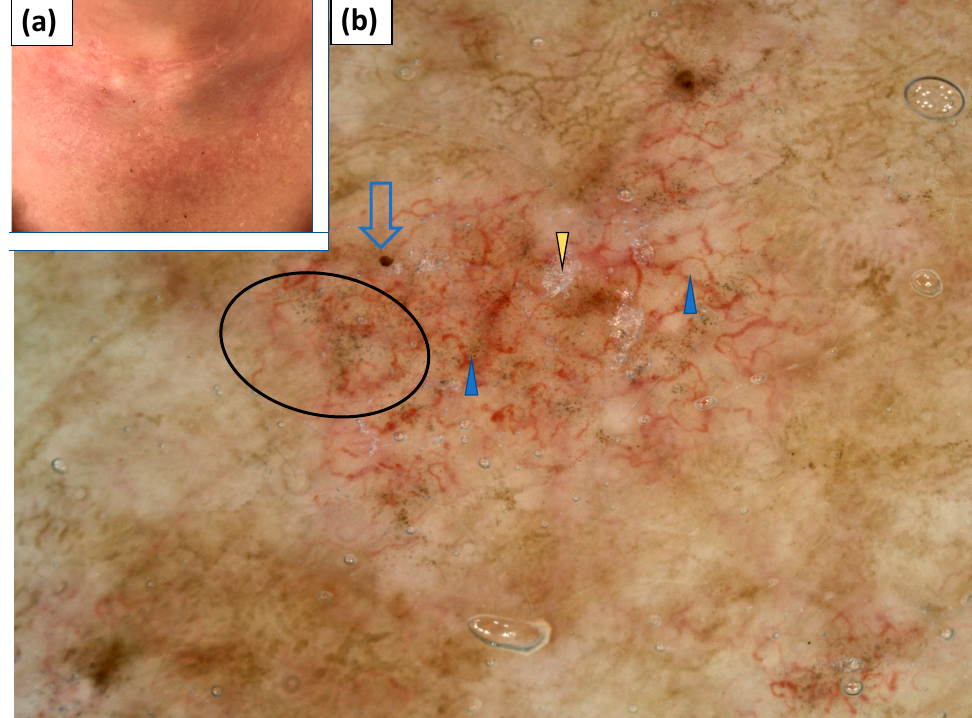
Figure 8. ( a ) Clinical presentation of V-neck sign. ( b ) Videodermoscopy of V-neck sign showed irregularly distributed linear vessels with branches (blue arrowhead), red hemorrhagic globules (blue arrow), grey dots (black circle), and white scaling of patchy distribution (yellow arrowhead) .